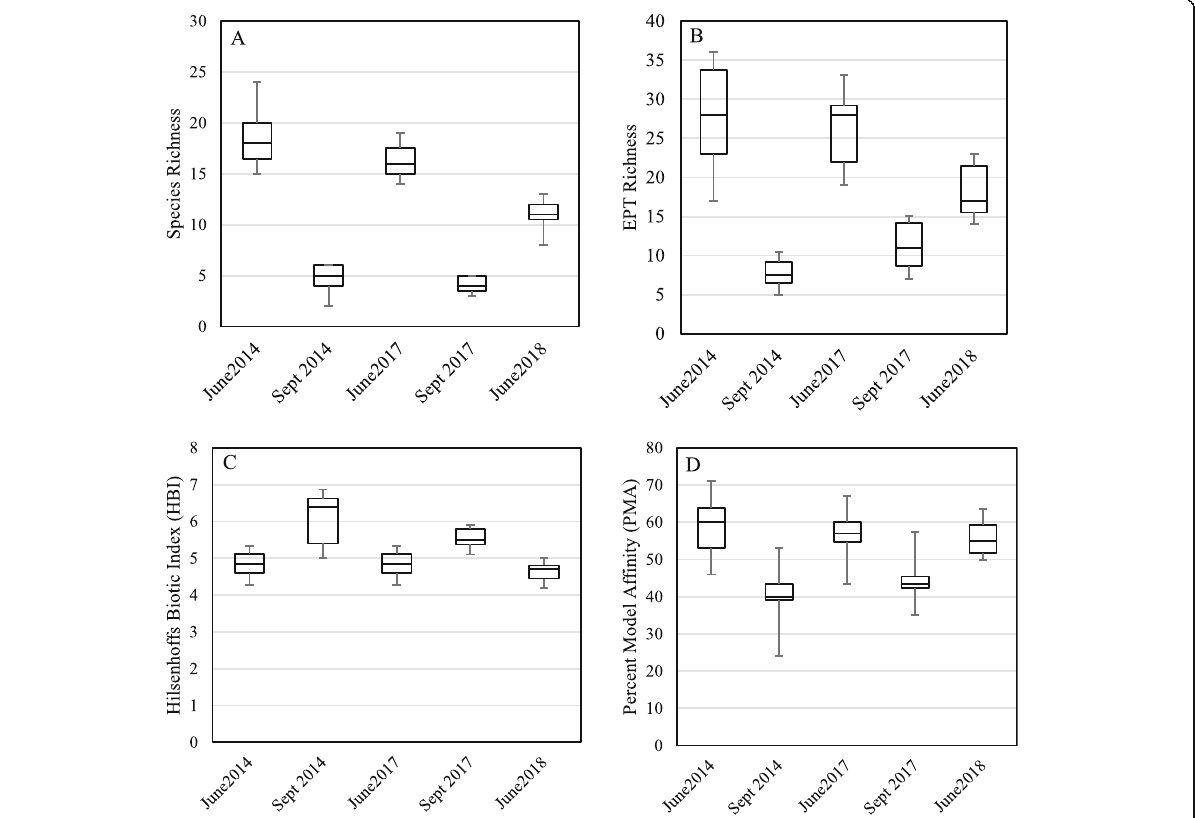
Fig. 5 Boxplots illustrating the median, 25th and 75th percentiles and outliers for a species richness; b Ephemeroptera, Plecoptera, and Trichoptera richness (EPT) richness; c Hilsenhoff ’ s Biotic Index (HBI); and d percent model affinity (PMA) in all macroinvertebrate samples collected at seven sampling sites grouped by study month and